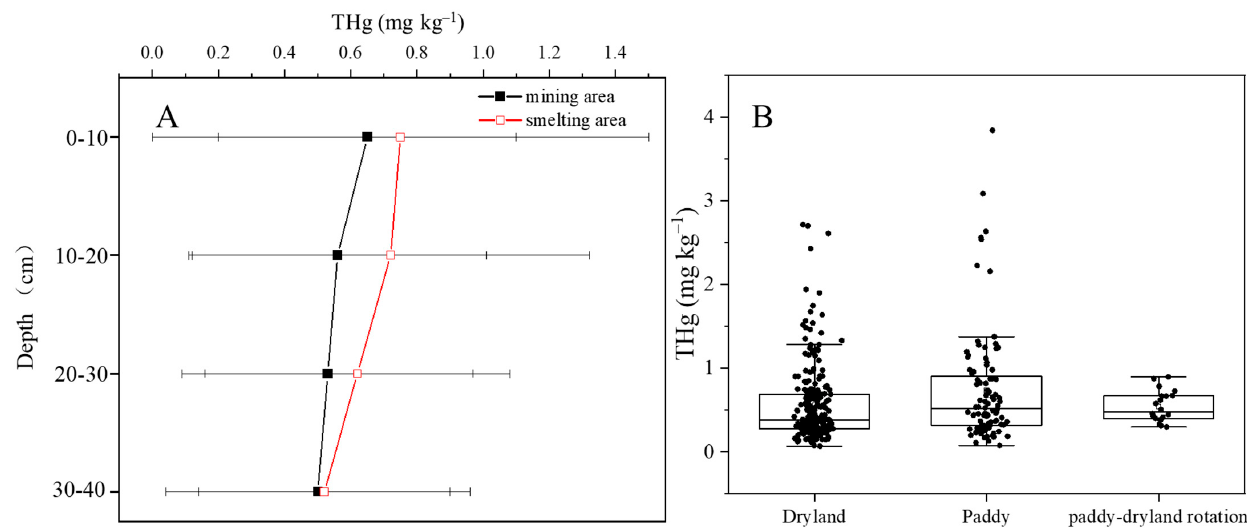
Figure 3. Distribution of total Hg in soil in different profiles ( A ) and land-used styles ( B ).